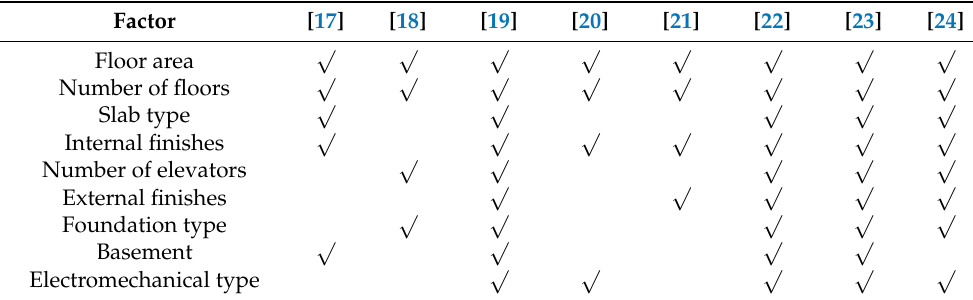
Table 1. Sources of parameters influencing the cost